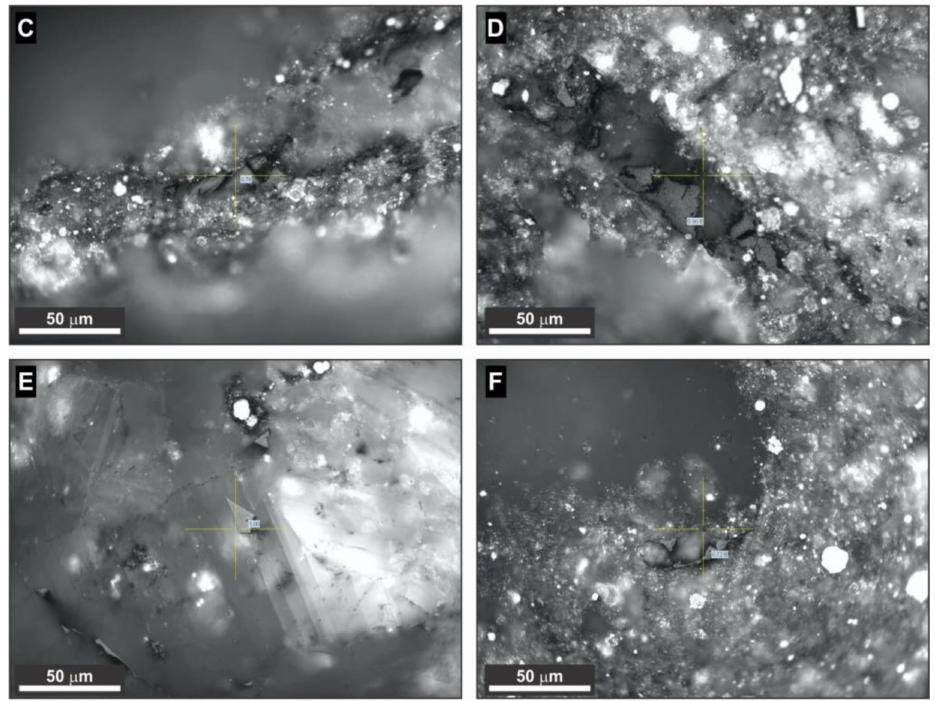
Figure 6. ( A – F ) Photomicrographs of solid bitumen B in whole-rock polished blocks under reflected white